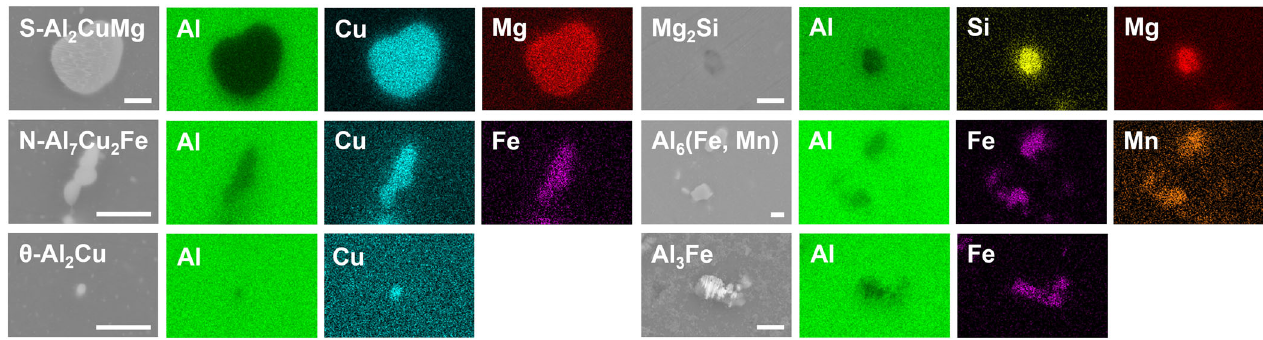
Fig. 5 Micron-scale IMCs or precipitated phases in Al alloys. 2xxx ( θ -Al 2 Cu, S-Al 2 CuMg, N-Al 7 Cu 2 Fe, Mg 2 Si), 5xxx (Mg 2 Si, Al 6 (Fe, Mn)), 6xxx (Mg